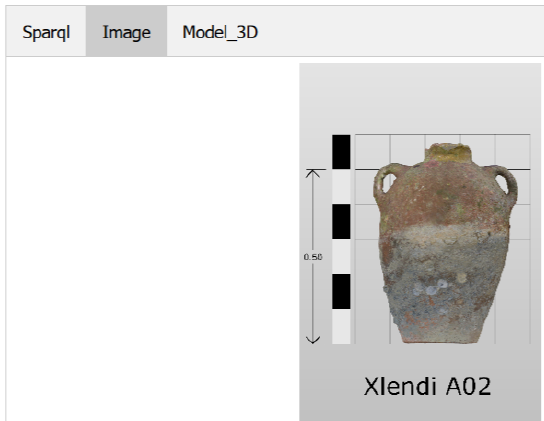
Figure 7: An image display tab of artifacts in the Xlendi 2D Web tool corresponding to the Amphorae A02 as the selection in the Figure